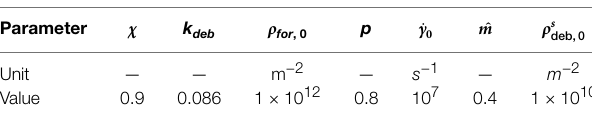
TABLE 7 | Hardening parameters.